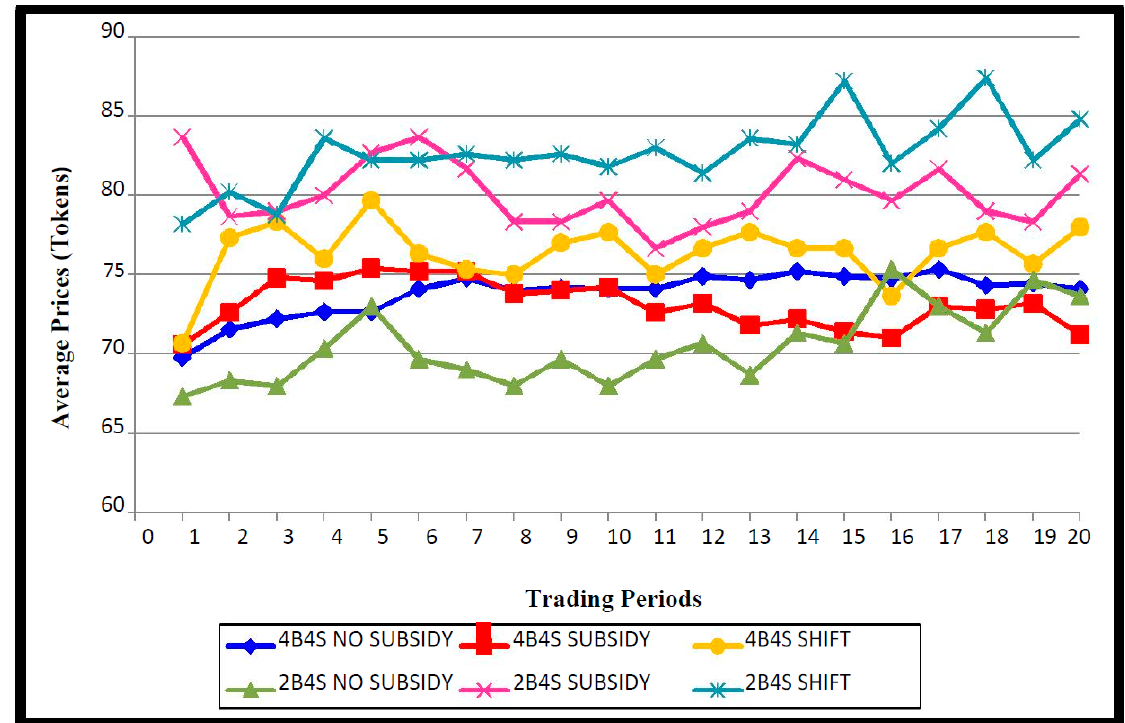
Figure 2. Average prices per trading period by treatment.